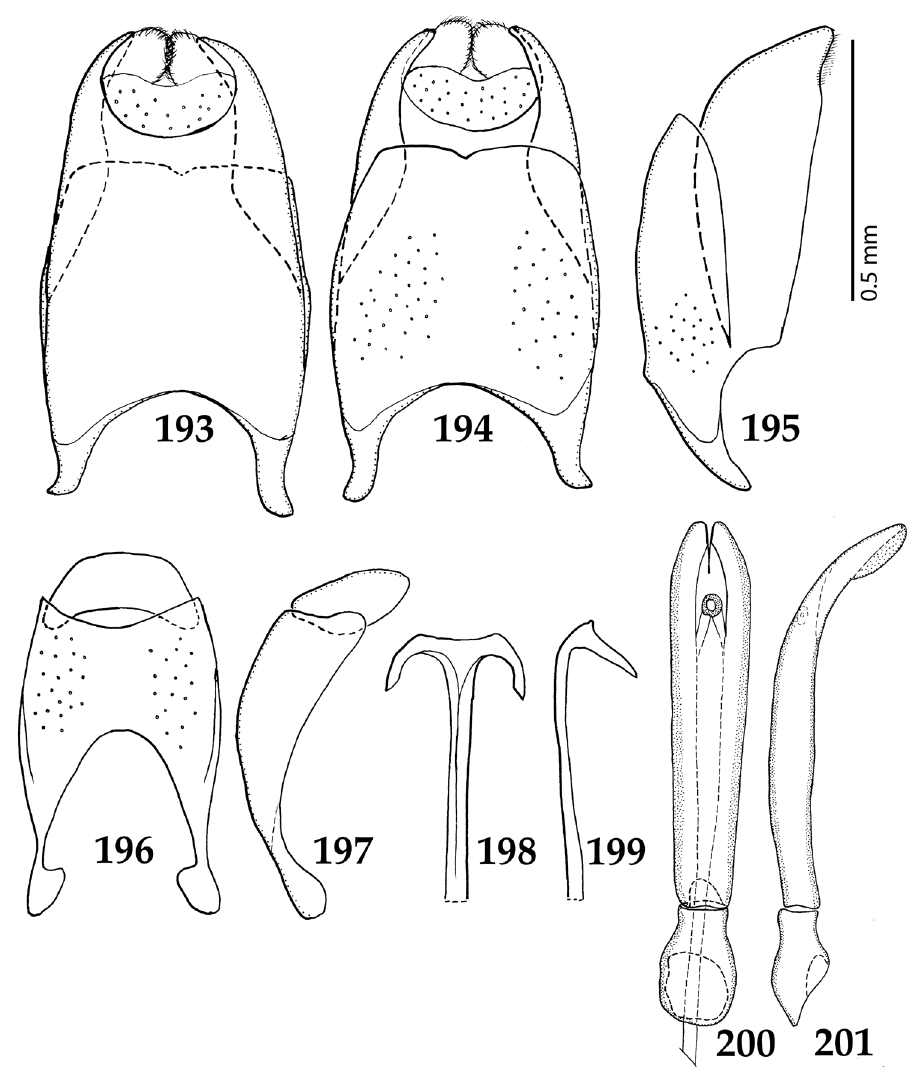
Figures 193–201. 193 Hypocaccus ( Baeckmanniolus ) varians varians (Schmidt, 1890) male terminalia: 8 th sternite + 8 th tergite, ventral view 194 ditto, dorsal view 195 ditto, lateral view 196 male terminalia: 9 th + 10 th tergites, dorsal view 197 ditto, lateral view 198 male terminalia: spiculum gastrale, ventral view 199 ditto, lateral view 200 male terminalia: aedeagus, dorsal view 201 ditto, lateral view. metatibia supplemented by another 2 (occasionally 3) denticles between the two rows. The presence of vague and weakened pronotal punctation and by possessing denticles between the two rows on the outer margin of metatibia, this species repre- sents a transitional form between the two subgenera and its exact taxonomic position should be determined by a thorough morphological study of all known species